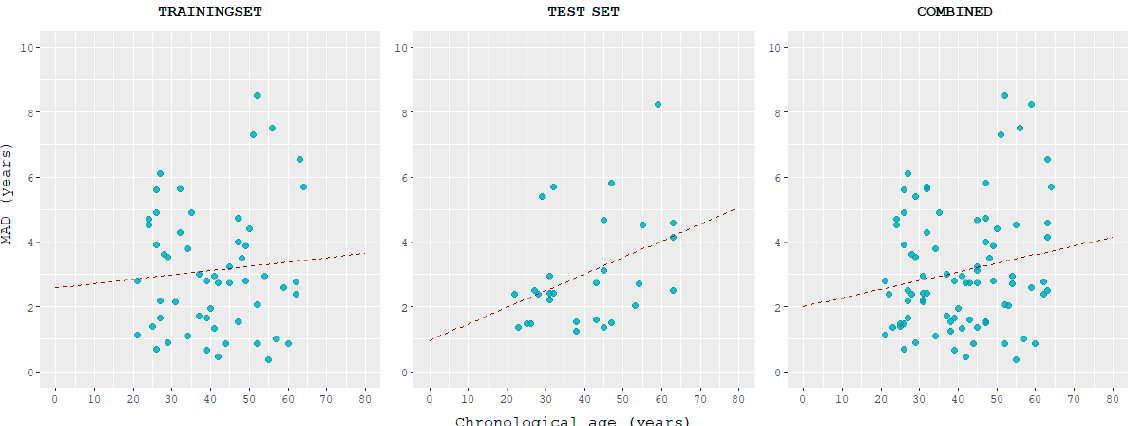
Figure 5. Correlation of MAD and chronological age in the training, test, and combined sets in the 4 markers model. Samples are sorted in ascending order of age.